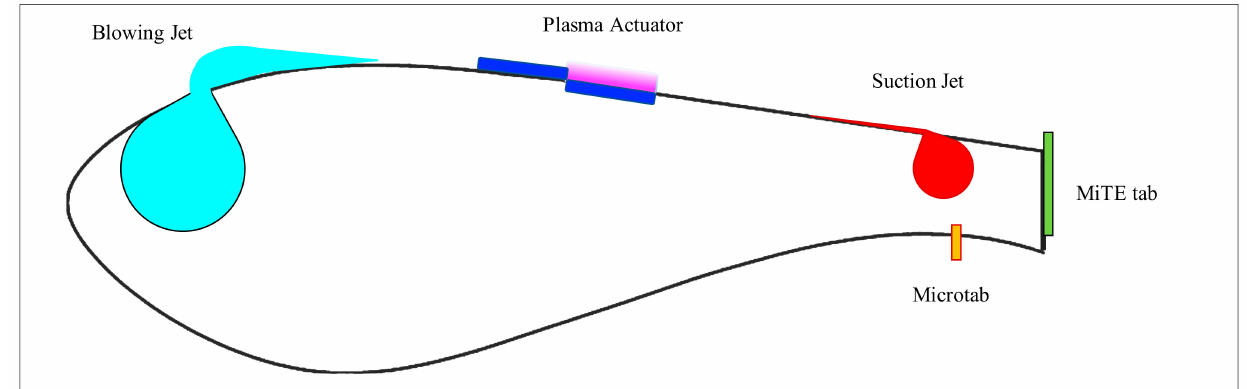
Figure 6. A wind turbine airfoil equipped with various flow control